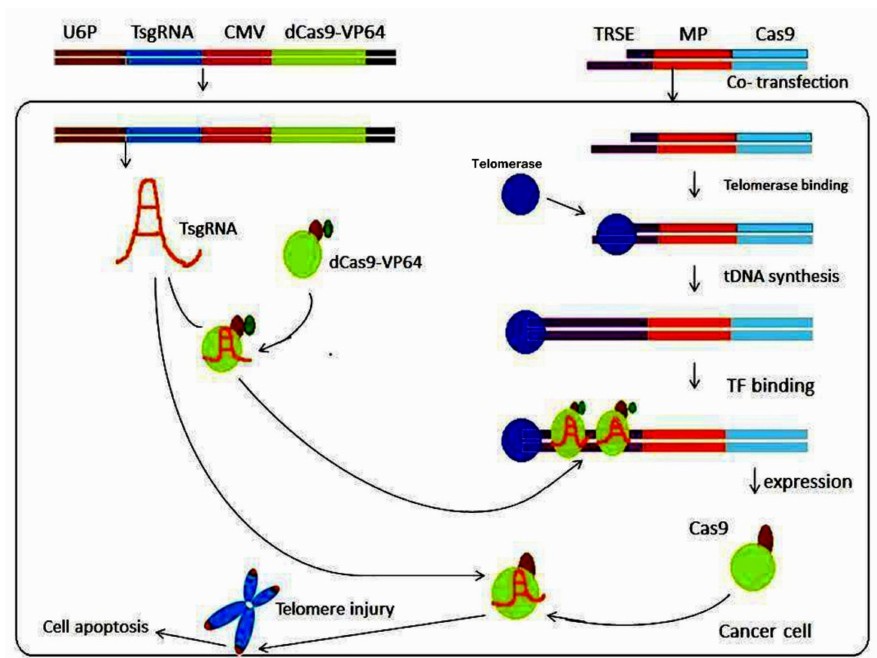
Figure 4. Schematic depiction of the Tage system’s cancer-killing mechanism. In this technique, cancer cells are transfected with an effector containing a telomerase-recognizable 3 (cid:48) ss sequence that can be extended by telomerase and yield a synthesized ds telomeric repeat sequence. The dCas9-VP64-TsgRNA complex, which recognizes and binds to telomerase-synthesized ds telomeric repeat sequences, is generated by co-transfecting cancer cells with a sgRNA targeting telomeric DNA (TsgRNA) and an artificial transcription factor expression vector (dCas9-VP64). In this way, an effector gene known as cas9 can be triggered. Cancer cells can be killed by the Cas9-TsgRNA complex, which can cut telomeres to cause DNA damage and hence trigger cell death. U6P, U6 promoter; TsgRNA, telomeric DNA-targeting sgRNA; pCMV, human Cytomegalie virus promoter; TRSE, telomerase- recognizable sticky end; MP, minimal promoter; tDNA, telomeric DNA; TF, transcription factor. Modified from